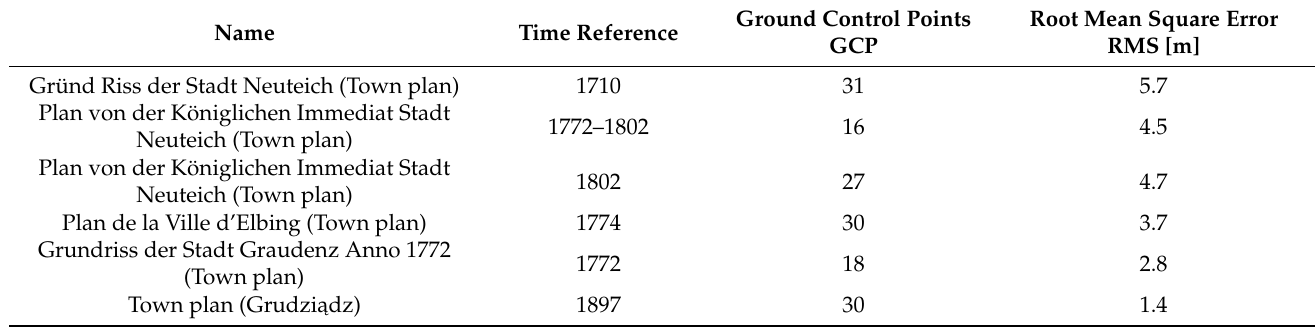
Table 2. Characteristics of the quality of spatial matching of source materials, summary of Ground Control Points (GCP) and Root Mean Square Errors